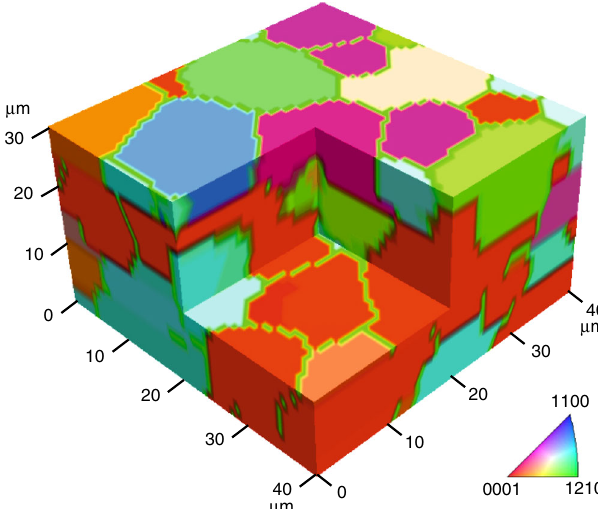
Fig. 5 3D-SAROM on a polycrystalline sapphire sample. The colors refer to orientations as shown by the inverse pole fi gure (inserted). The green boundaries between grains were generated as part of the segmentation procedure (Supplementary Figs. 32 – 34, Table S1). SAROM was performed at a lateral step size of 0.7 µ m, axial step size of 1.7 µ m. Map dimension is 57 × 56 × 18 pixels or 40 × 39.2 × 30.6 µ m with an average exposure time per step of 180